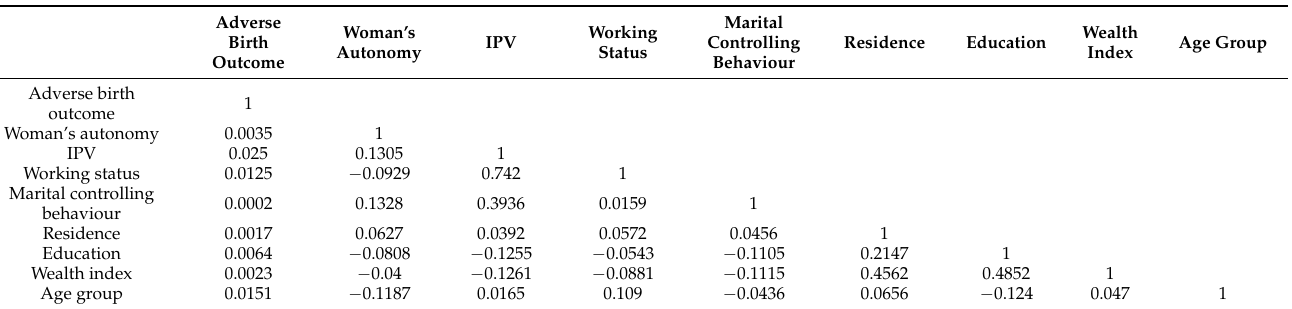
Table A1. Correlation matrix of the studied